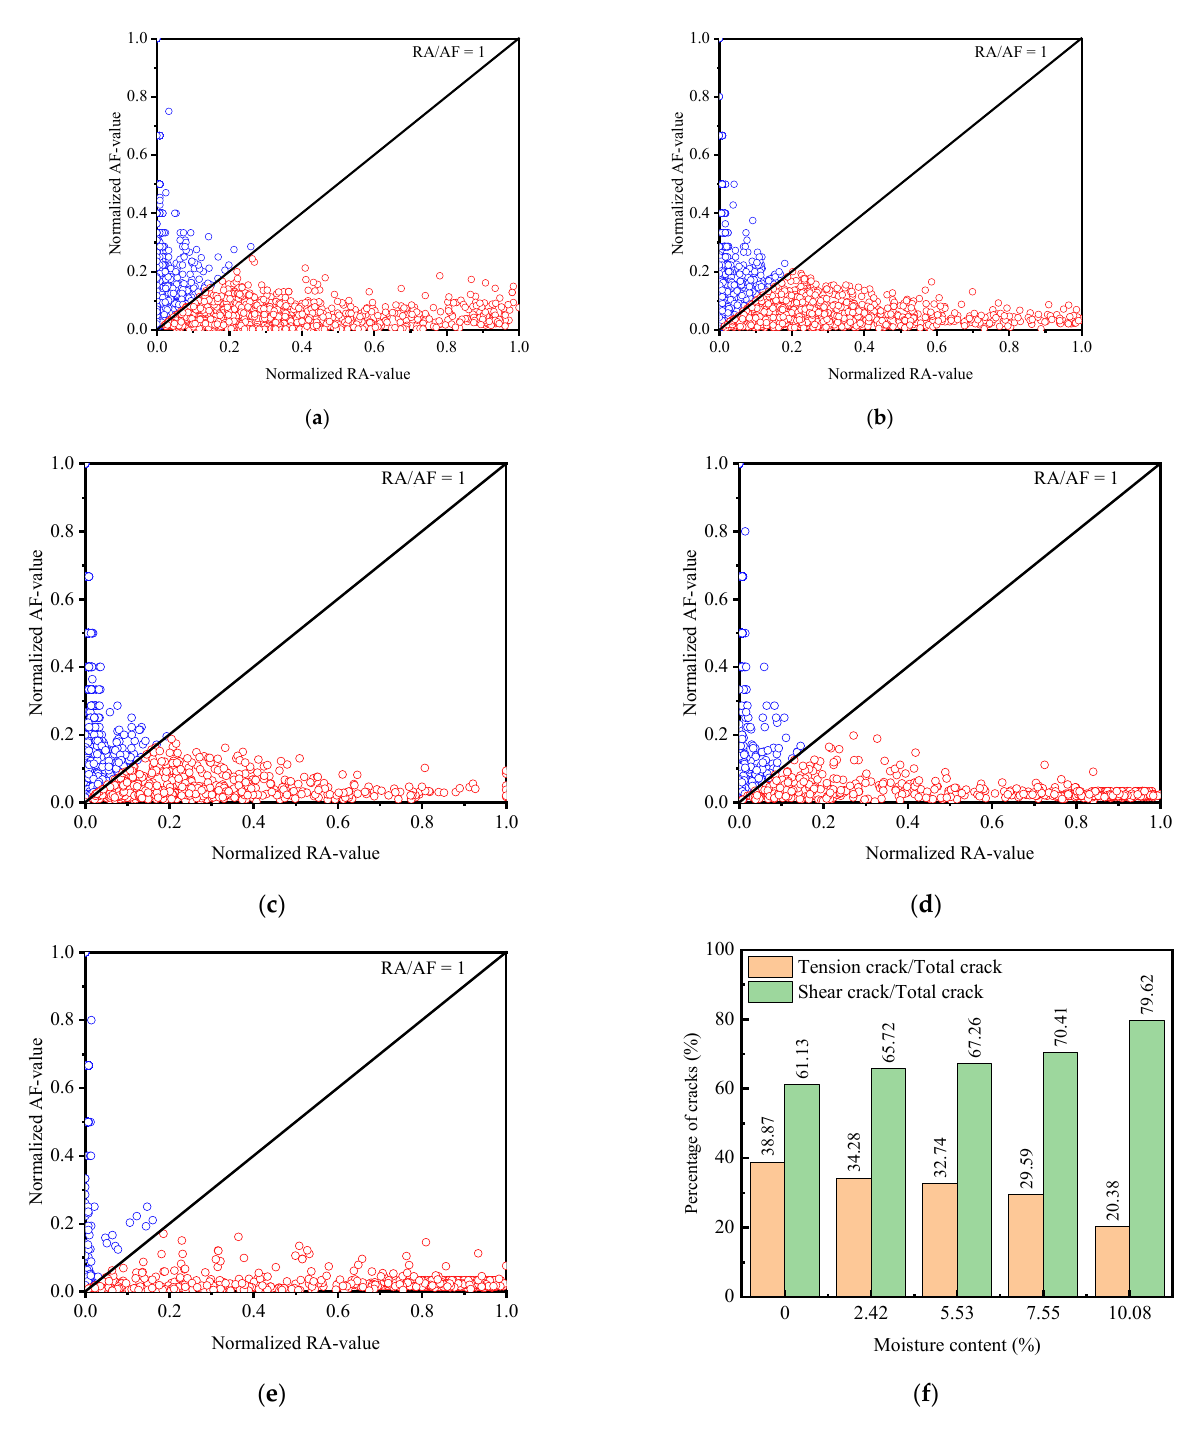
Figure 11. Evolution of tension–shear cracks in coal specimens at different inclination angles ( θ = 0°). ( a ) ω = 0%; ( b ) ω = 2.42%; ( c ) ω = 5.53%; ( d ) ω = 7.55%; ( e ) ω = 10.08%; ( f ) The ratio of tensile and shear cracks in coal specimens under different moisture contents. Figure 12 shows the variation rule of the RA–AF relationship curve with the moisture content when the inclination angle was 10°. Figure 12f shows the ratio of the number of tensile and shear cracks to the total number of cracks when the inclination angle was 10°. At any moisture content, the proportion of shear cracks was greater than 50%, and with the increase in the moisture content, the shear failure trend gradually increased, and the sample mainly exhibited shear failure, as shown in Figure 12f.